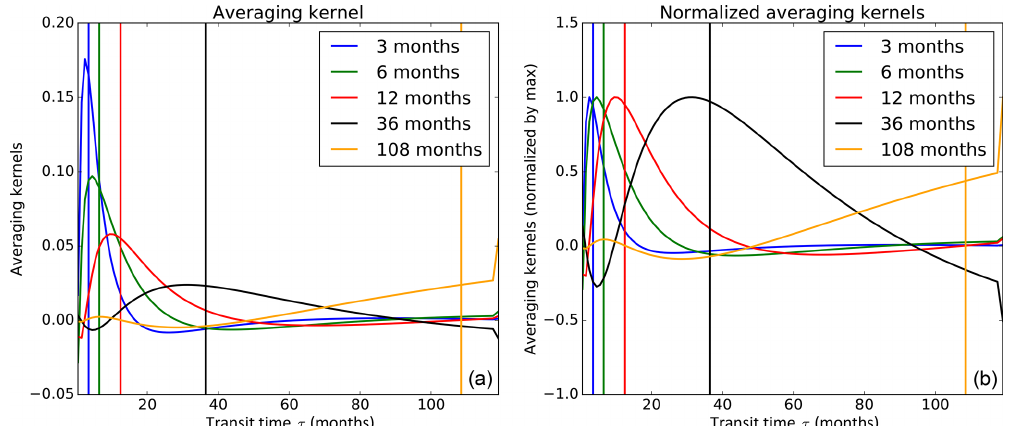
Figure 4. Averaging kernels to the age spectrum for different retrieved transit times with the high-resolution (1 month) retrieval. (a) Actual averaging kernels. (b) Averaging kernels normalized by their respective maximum value. Note that the averaging kernel at a particular transit time is the respective row of the averaging kernel